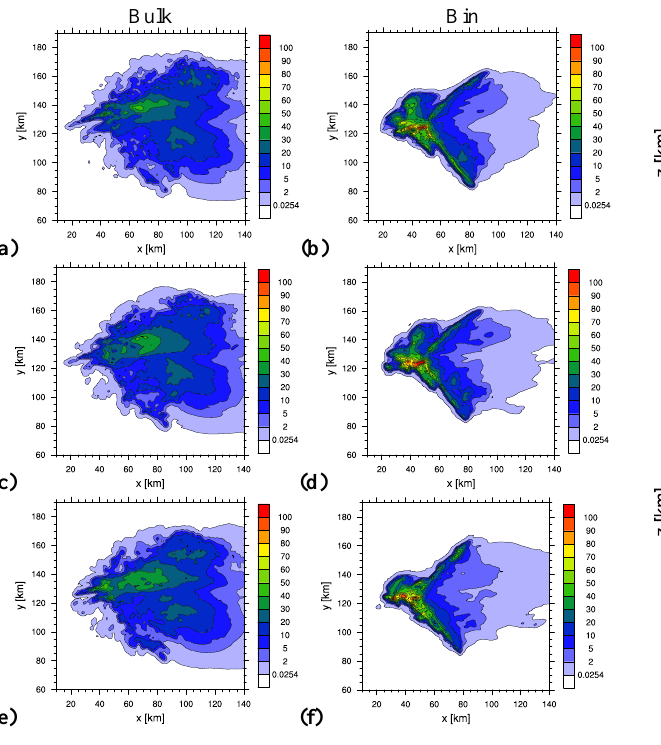
Fig. 11. As in Fig. 10 except after 4h of simulation time.